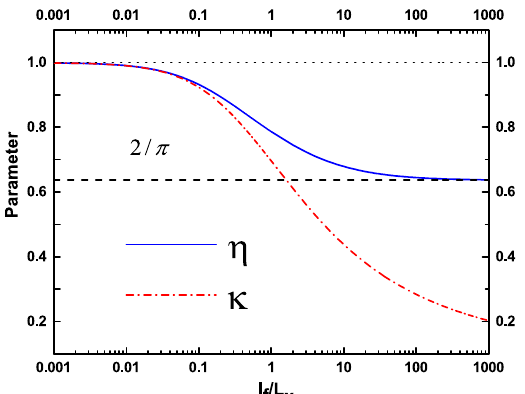
Figure 2. Parameters η and κ as functions of l L /